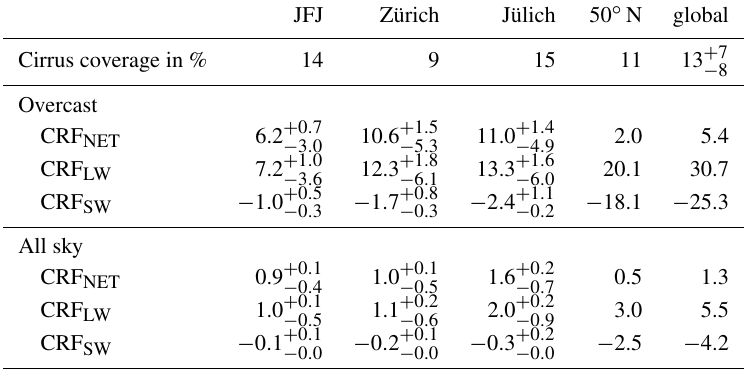
Table 3. Cirrus radiative forcing at the Top of Atmosphere in Wm − 2 for Jungfraujoch, Zürich, and Jülich, as compared to 50 ◦ N zonally averaged and globally averaged values provided by Chen et al. (2000). Small numbers in CRF values indicate uncertainty ranges according to the last paragraph of Sect. 2.1. Small numbers in global cloud coverage indicates variability in zonal averages. JFJ Zürich Jülich 50 ◦ N